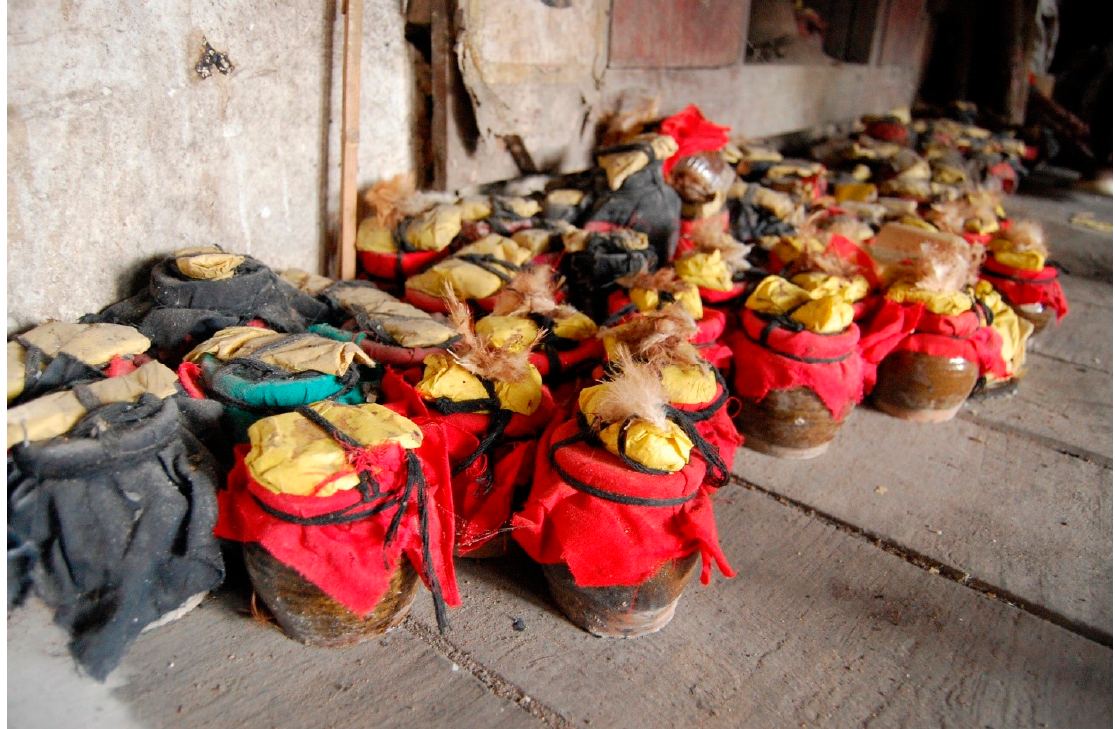
Figure 8. Rows of earthenware jars containing spirits. Altar of Chen Demei (Hunan). Photo by author.